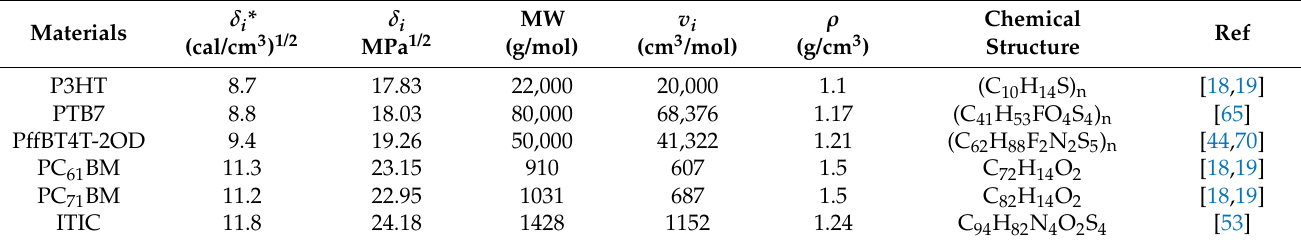
Table 1. Solubility parameter ( δ i ), molecular weight (MW), molar volume ( v i ), density ( ρ ), chemical structure and reference for materials. Here, MW is M n in the case of polymers.